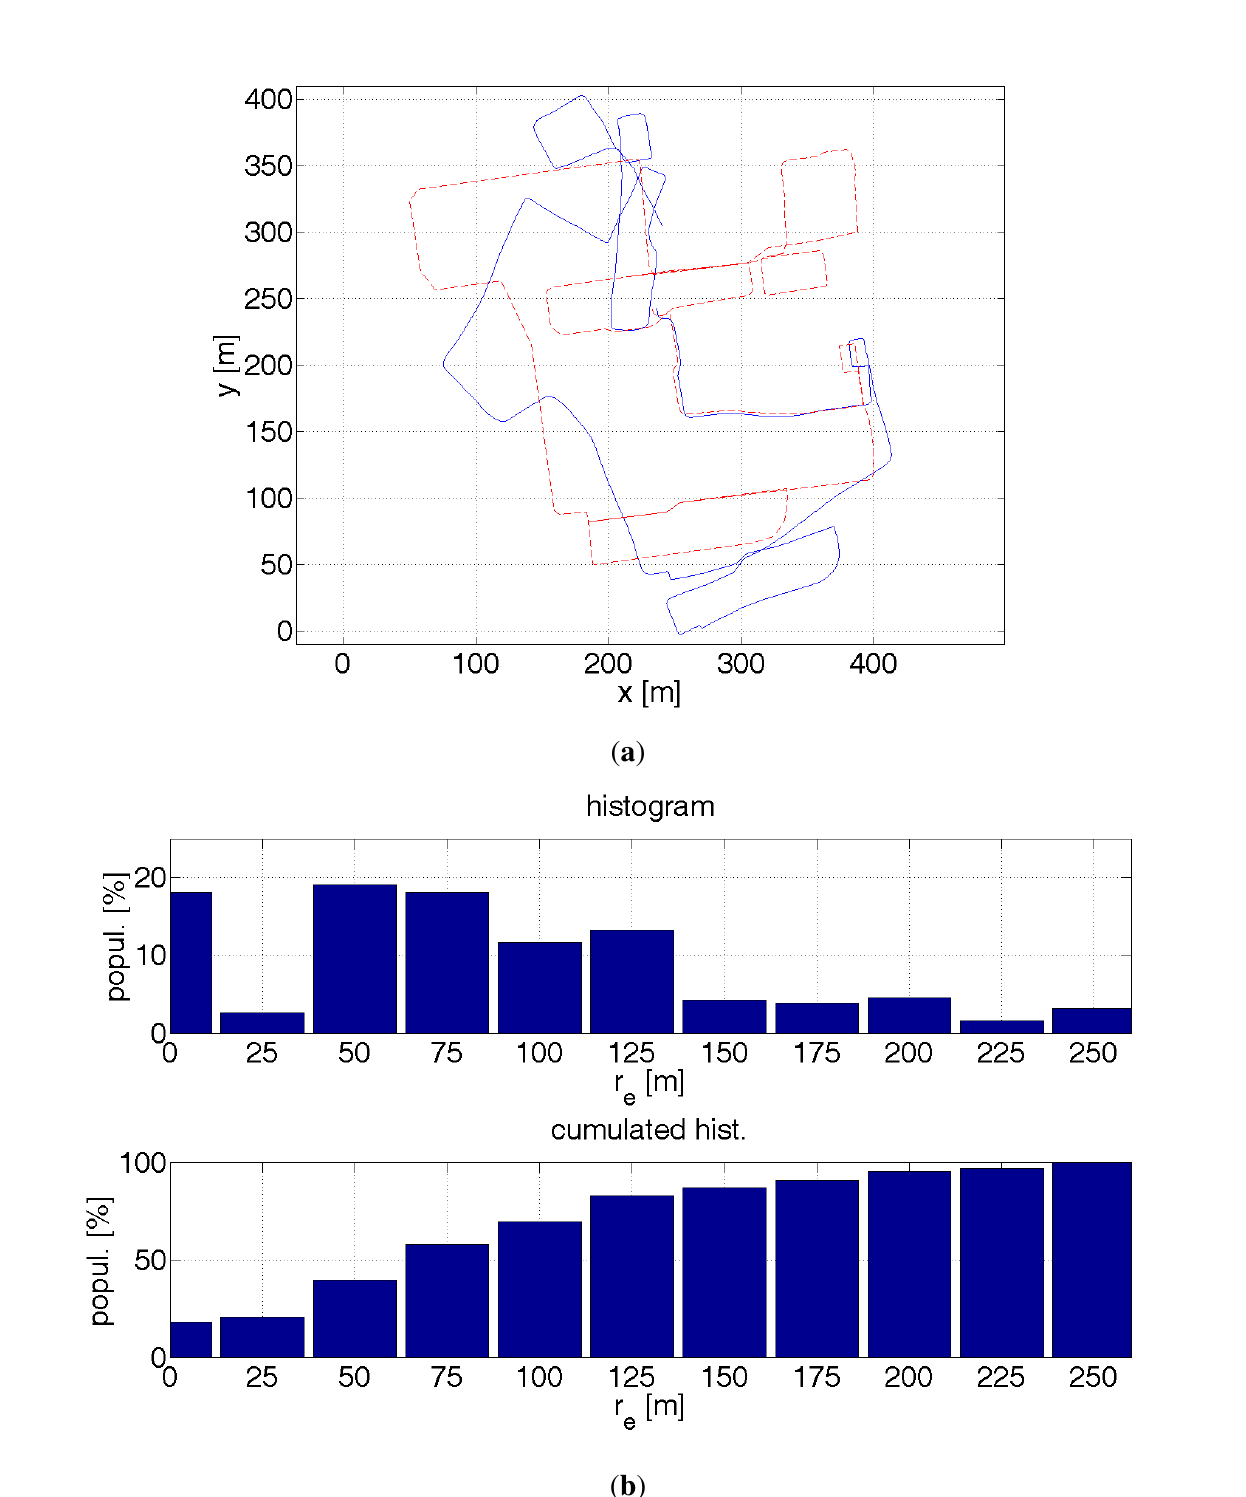
Figure 22. ( a ) Red dashed line—reference path. Blue solid line—estimated path with a help of the inertial sensors, i.e. , gyroscope for estimating direction change and accelerometers for counting steps and their lengths. As times goes on, the errors accumulate due to angular random walk. ( b ) Histograms of distance